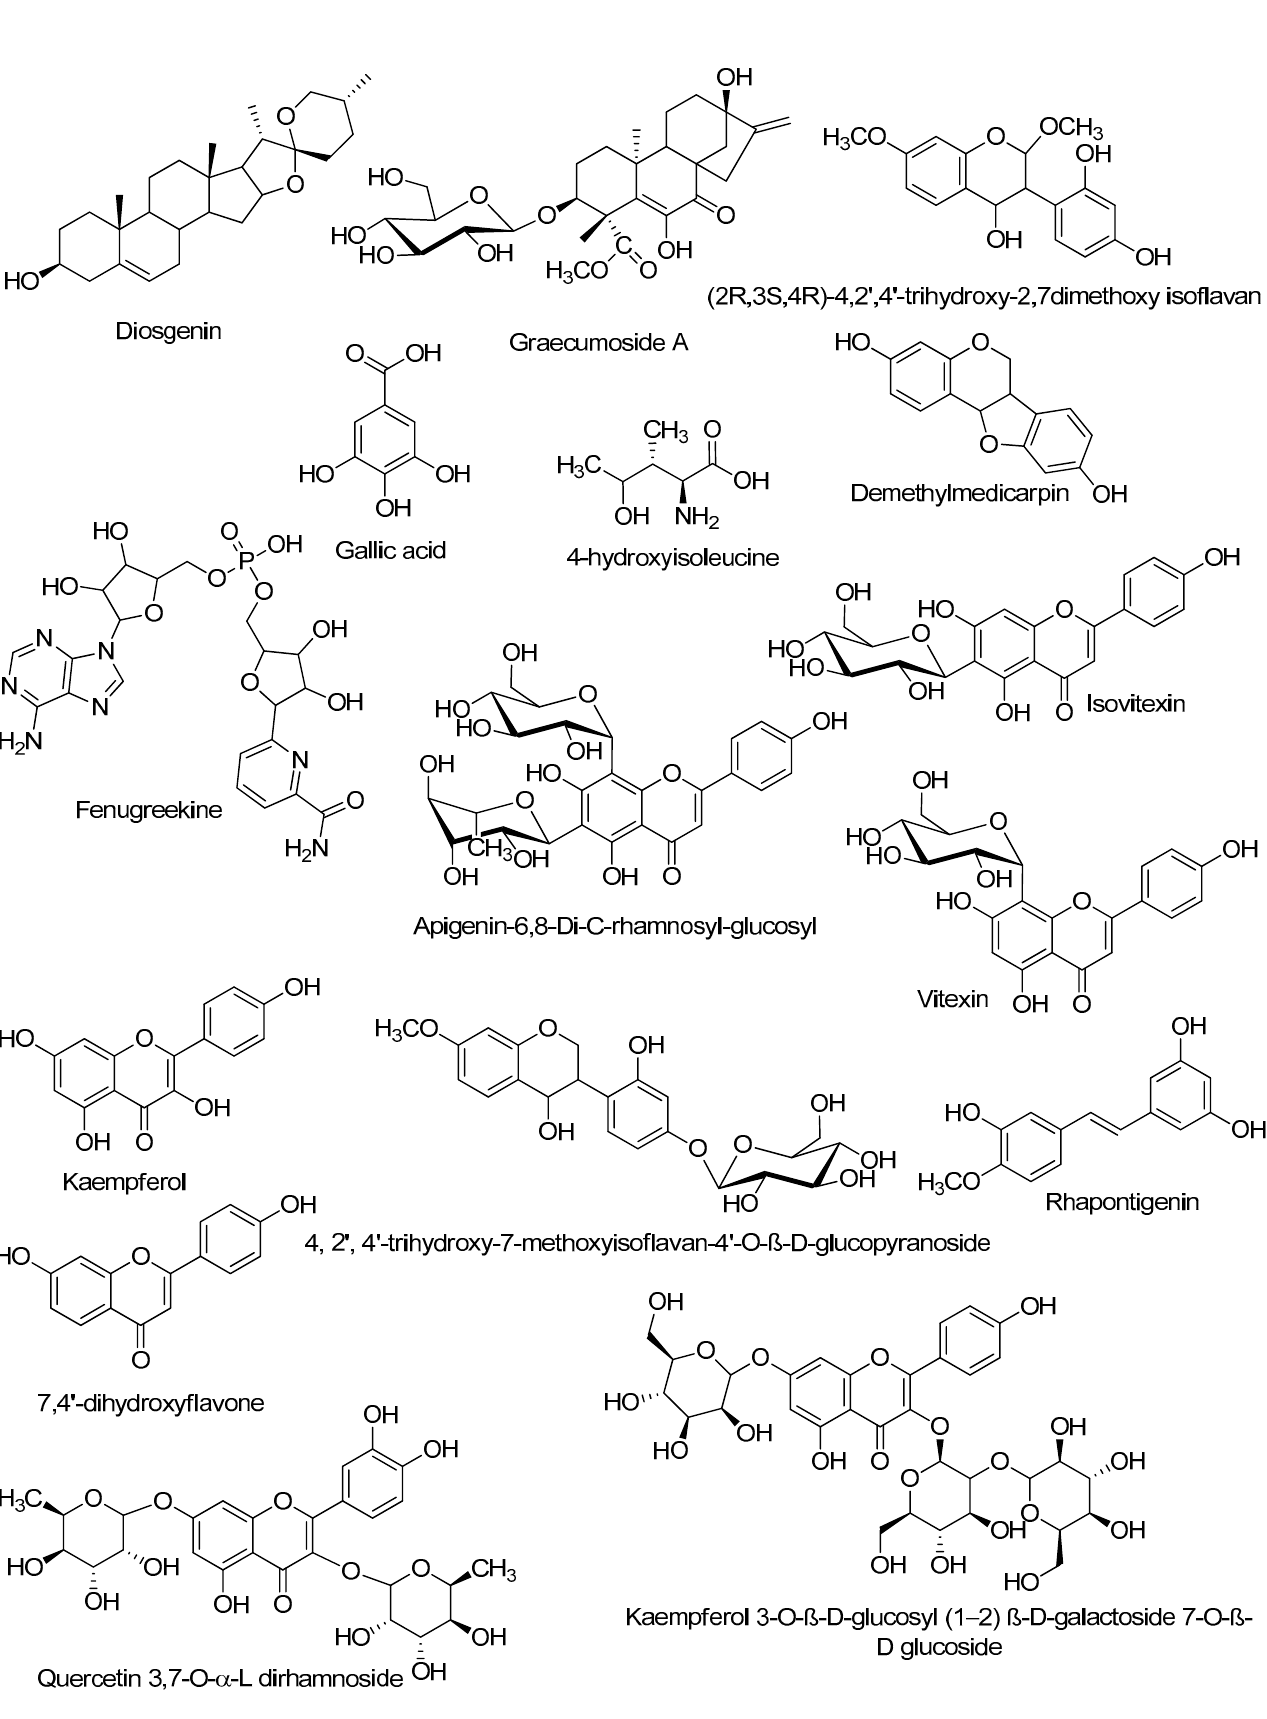
Figure 2. Structures of the dereplicated compounds from Trigonella stellata methanolic extract by LC-HRESIMS.